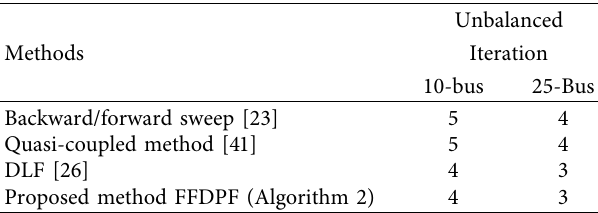
Figure 7: Unbalanced 25-bus radial distribution system. Table 3: Comparison of iterations of the balanced 10-bus and 25- bus system.